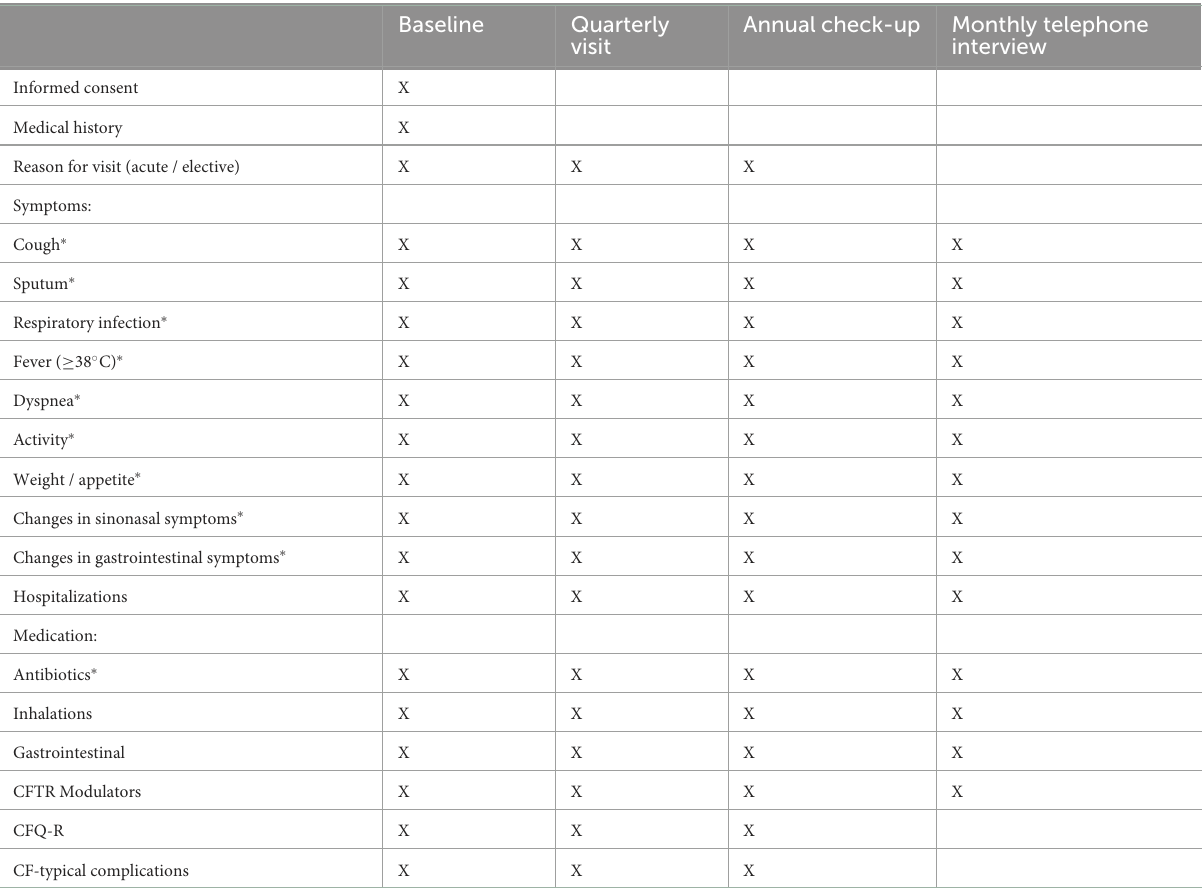
TABLE 1 Questionnaire and timepoints.